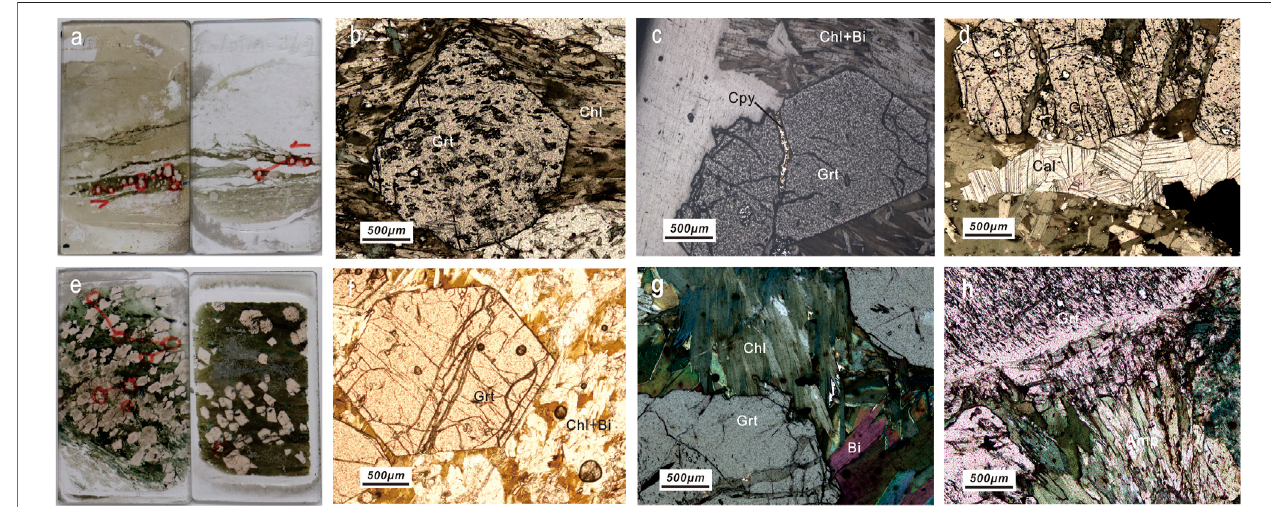
FIGURE 4 | Photographs of the garnets from the Tiemurt Pb – Zn – Cu deposit. (A) Thin sections (Nos. 10TM-26-1 and 10TM-26-2). (B) Photomicrograph of the sub-toeuhedralmineralinclusion – richGrt1withchlorite(underthere fl ectedlight). (C) PhotomicrographsofGrt1garnetintergrownwithchloriteandbiotite,beingcutby chalcopyrite veinlet (under the plane-polarized light). (D) Garnet grains in 10TM-26-1 intergrown with chlorite and calcite. (E) Thin sections (No. 10TMZK-49). (F) PhotomicrographofthemineralpoorGrt2intergrownwithchloriteandbiotite(underthecross-polarizedlight). (G) PhotomicrographofGrt2coexistingwithchlorite and biotite (under thecross-polarized light). (H) Garnetgrainsin10TMZK-49 coexist withamphibole.Abbreviations:Amphibole (cid:1) Amp,Biotite (cid:1) Bi,Chalcopyrite (cid:1) Cpy, Chlorite (cid:1) Chl, Calcite (cid:1) Cal, Chalcopyrite (cid:1) Cpy, and Garnet (cid:1) Grt.